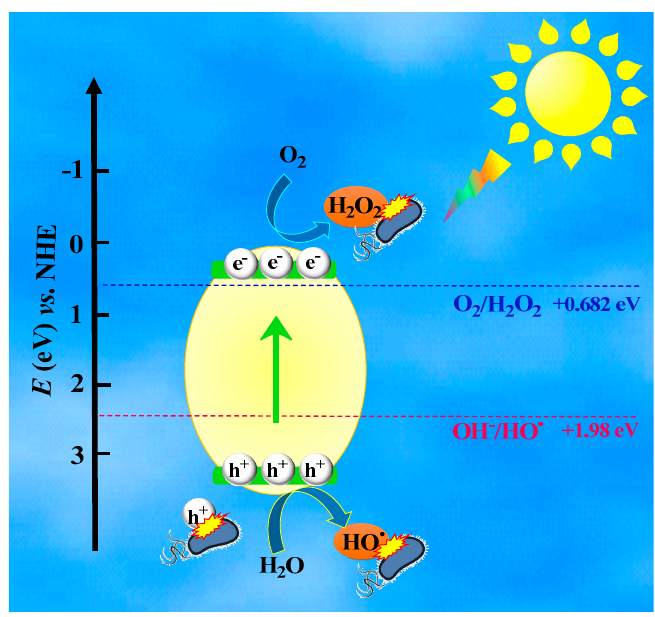
Scheme 3. Schematic diagram showing the photocatalytic inactivation of bacteria on the Bi 2 WO 6 .